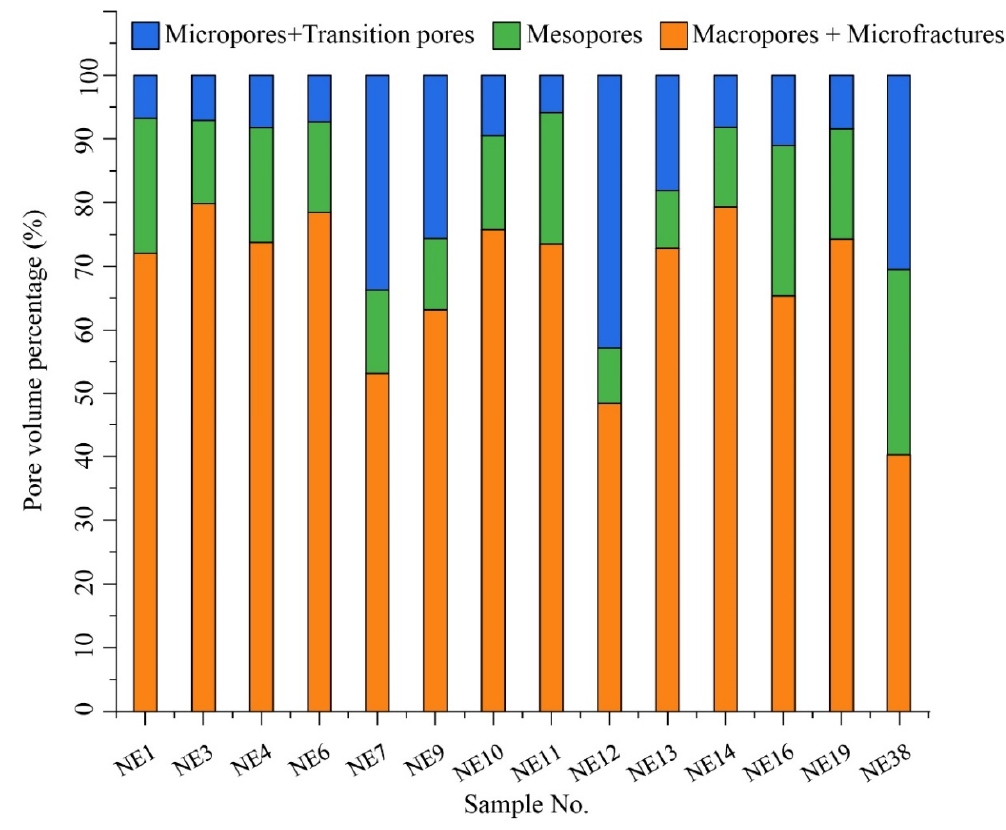
Figure 3. The pore volume distribution of selected coals from Sangjiang-Muling coal-bearing basins.